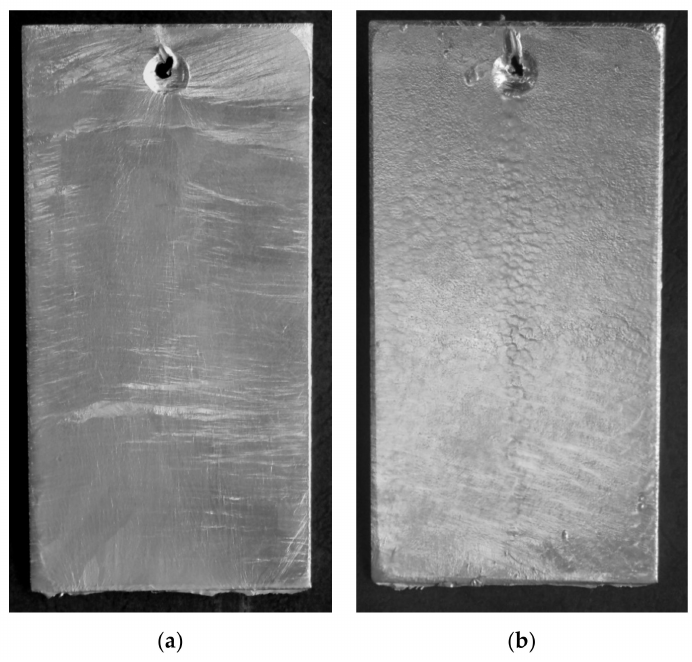
Figure 1. The top surface outlook of coatings made in: ( a ) Zn-AlNiBiSn, ( b ) Zn-AlNi baths.